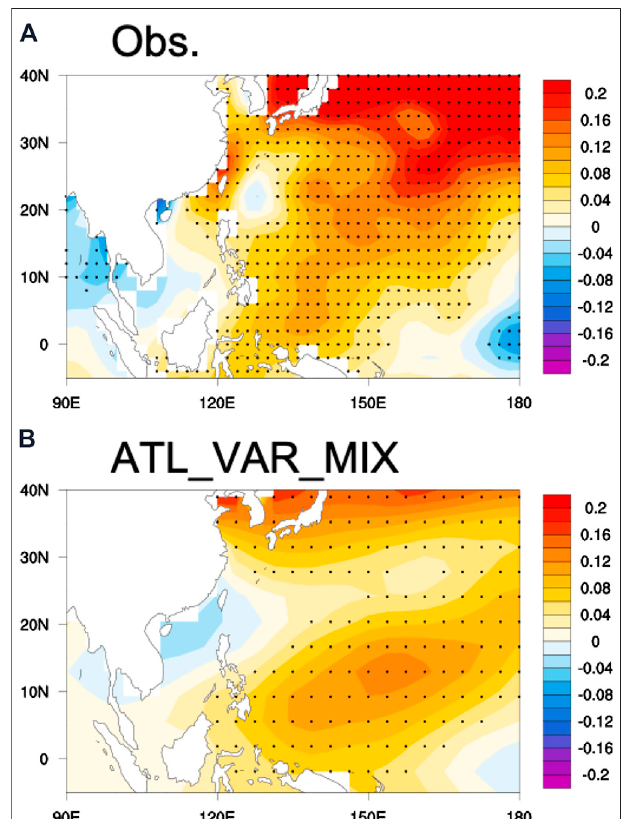
FIGURE 3 | (A) The regression map of SST anomalies (unit: K) onto the normalized AMO index based on the data from the ERSST data for 1950 – 2010. (B) As in (A) , but in the ATL_VARMIX experiment. The long-term linear trends in the SST data set were removed before the regression analysis, and dots indicate the regression coef fi cients signi fi cant at the 95% con fi dence